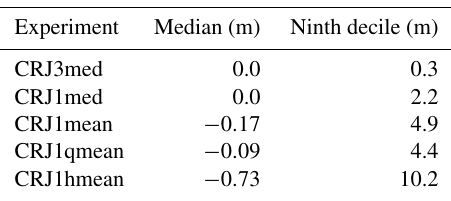
Table 3. Statistical metrics of the depth error distributions according to the depth parameterization strategy used: the median and ninth decile values are given in